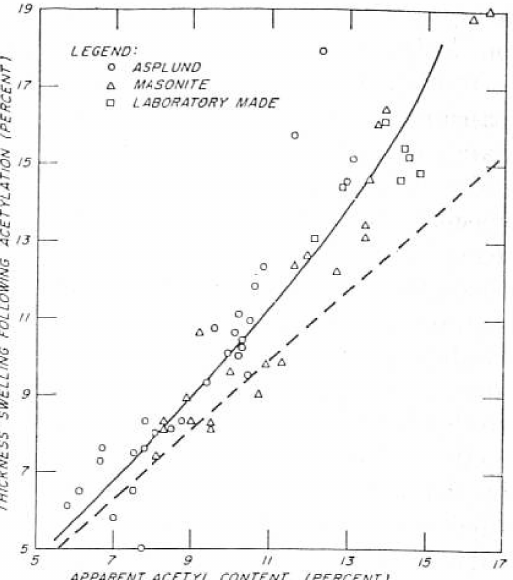
Figure 15. Thickness swelling in Asplund and Masonite hardboards due to acetylation. The dashed line represents the theoretical volume expansion using 0.90 cm 3 /g as the specific volume for the acetyl group